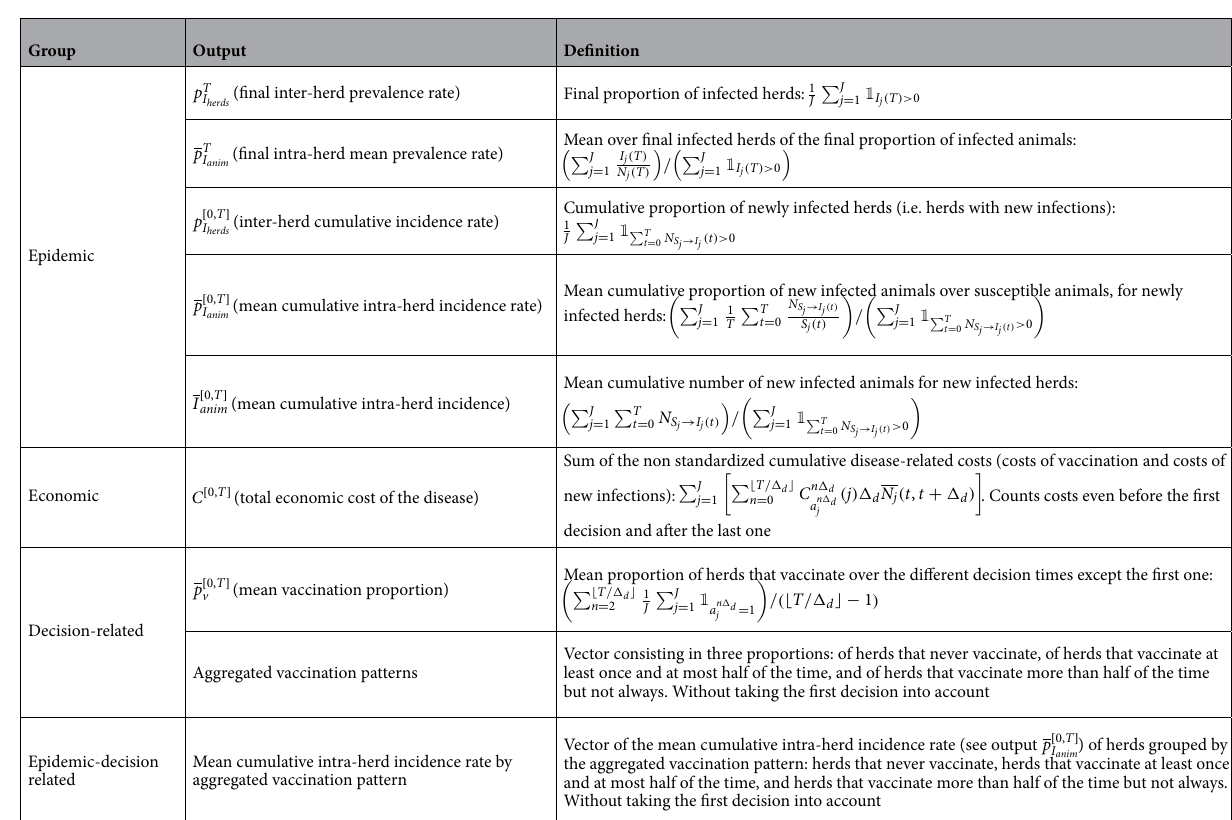
Table 2. Description of the outputs of the sensitivity